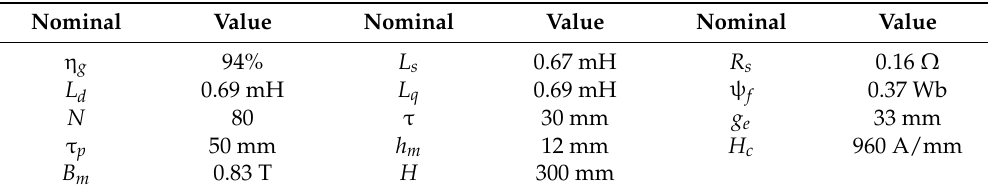
Table 6. LEM specifications.